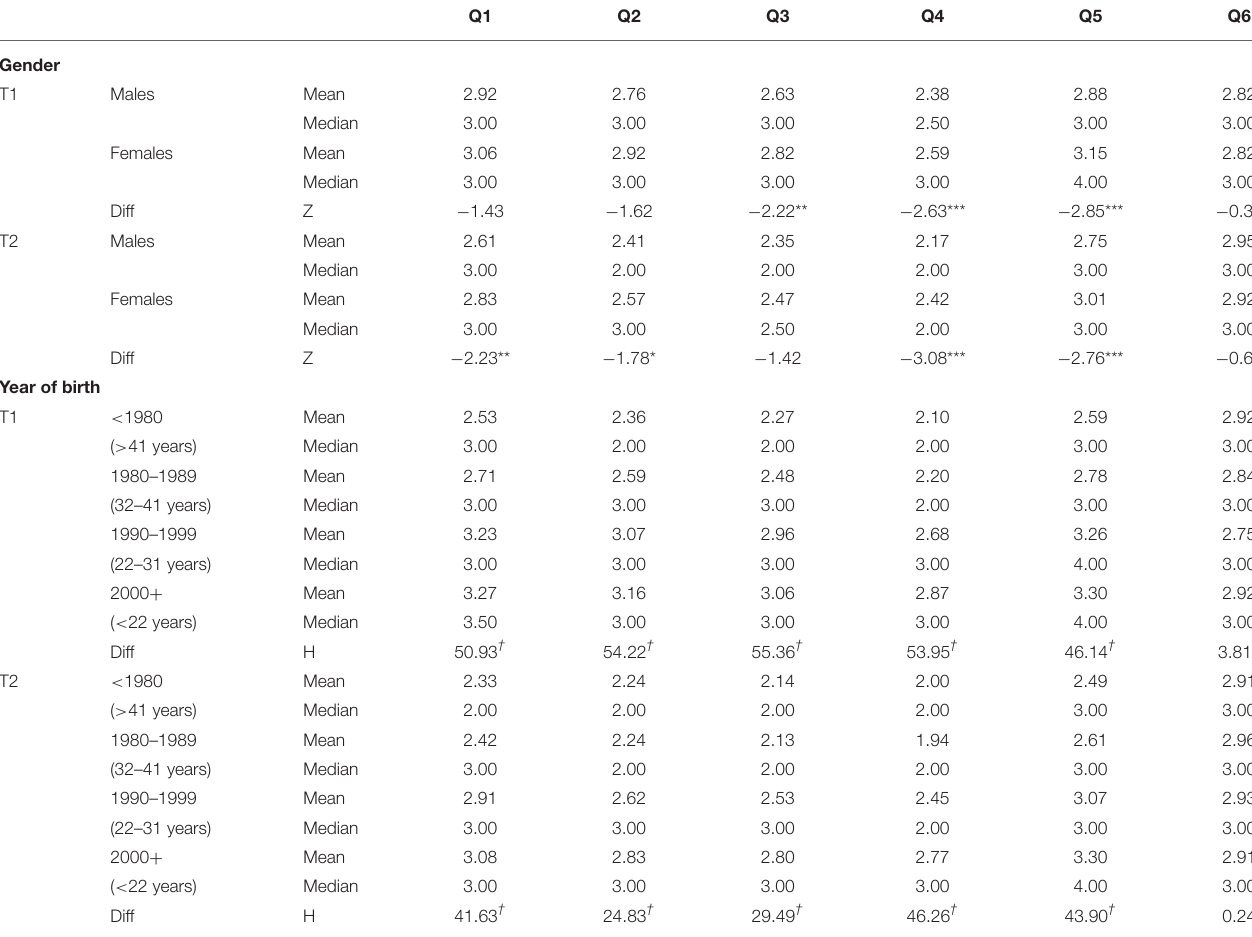
TABLE 3 | COVID-19 testing perceptions–the first test and the last test in the classification of gender and age. Q1